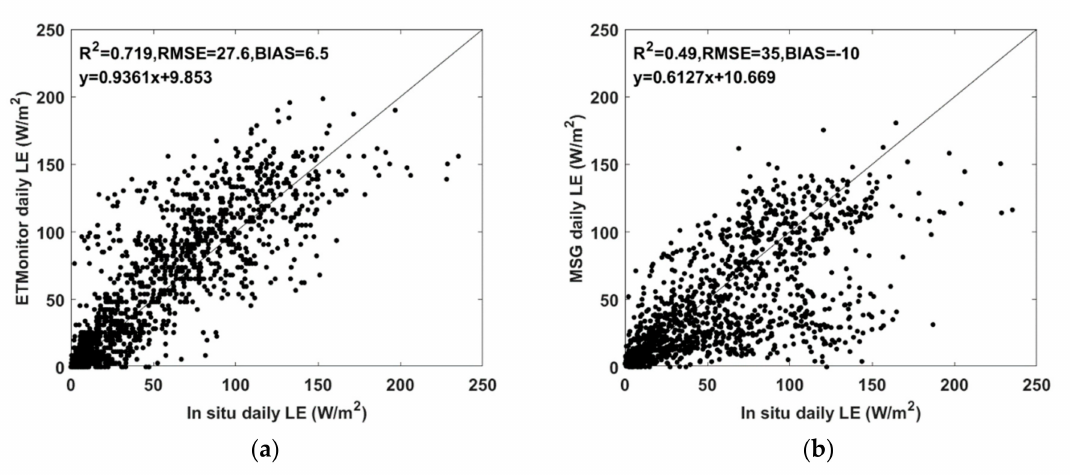
Figure 7. Comparisons of: ( a ) ETMonitor daily average LE ; and ( b ) MSG daily average LE with in situ measurements from the FLUXNET2015